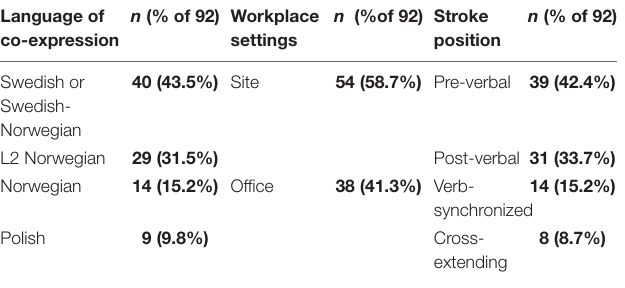
TABLE 1 | Dstribution of action-depicting gestures according to the language of co-expression, the settings of production, and the position of stroke in relation to the verbal